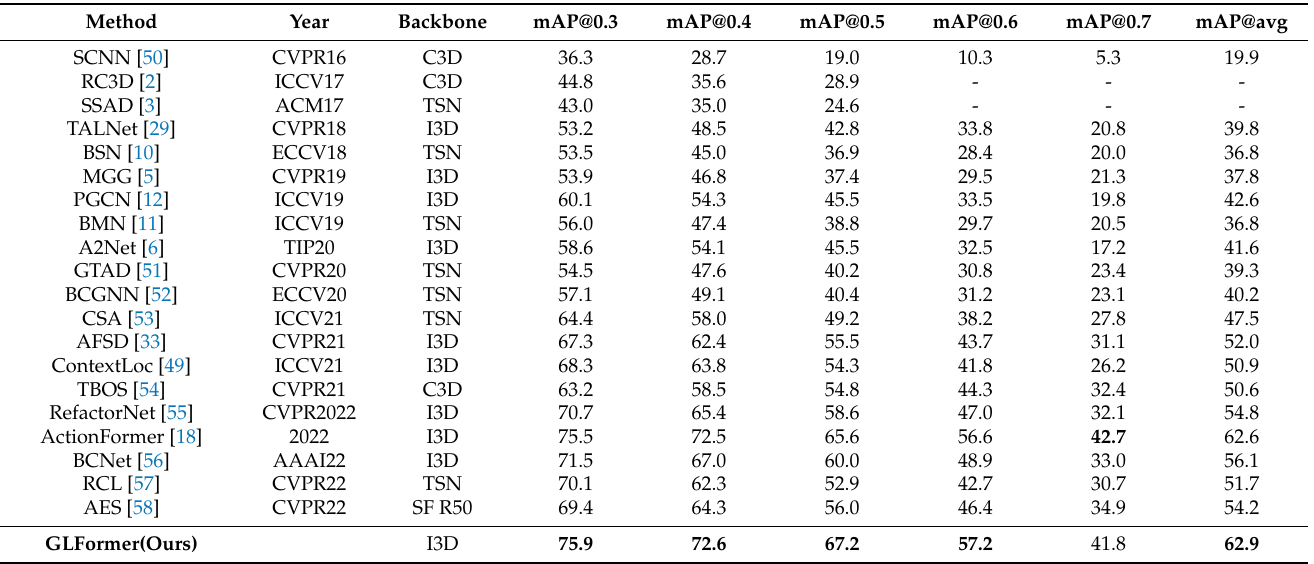
Table 2. Comparison with the state-of-the-art (THUMOS14), measured by the mAP at different tIoU thresholds and the average mAP in {0.3, 0.4, 0.5,0.6,0.7}; the best results are in bold.